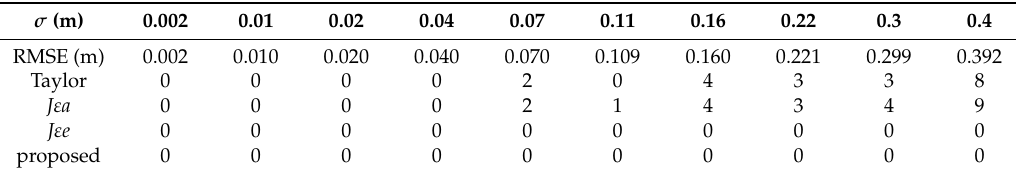
Table 3. RMSE and the divergence times along the error changing, p = (0, 0) T .